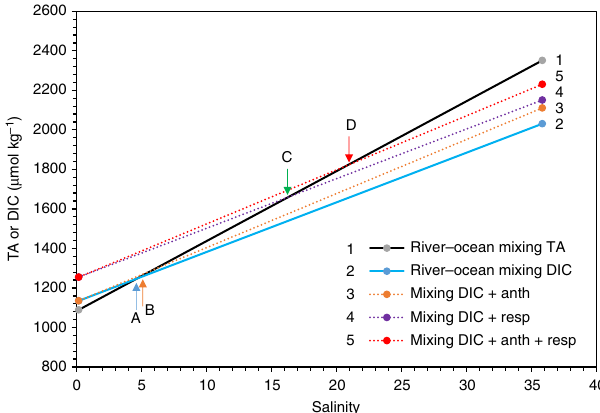
Fig. 6 Estuarine TA or DIC mixing lines between the river and ocean endmembers with additional CO 2 added in from anthropogenic sources and respiration. Line 1 is river-ocean mixing of TA, line 2 is river-ocean mixing of DIC, line 3 is mixing DIC plus anthropogenic CO 2 addition, line 4 is mixing DIC plus respiratory CO 2 addition, and line 5 is mixing DIC plus both anthropogenic and biological CO 2 additions. The crossover points are river – ocean mixing lines of TA with A river – ocean mixing lines of DIC, B mixing plus anthropogenic CO 2 , C mixing plus CO 2 from respiration, and D mixing plus CO 2 from both B and emphasize that subsurface H 2 S oxidation (~0.2 pH units) and local surface CO 2 uptake (~0.1 pH units) work together with known organic matter respiration and the open-ocean OA source estuarine subsurface waters. Currently, acidi fi cation due to CO 2 input from AR (up to 0.8 pH units) in the bay exceeds that from the atmospheric CO 2 increase in the open ocean (~0.1 pH units